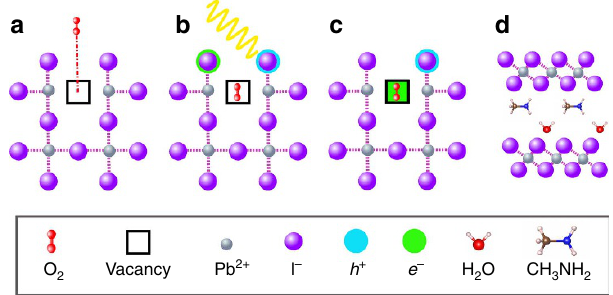
Figure 1 | Oxygen-induced photo-degradation. Schematic representation of the reaction steps of O 2 with CH 3 NH 3 PbI 3 . ( a ) Oxygen diffusion and incorporation into the lattice, ( b ) photoexcitation of CH 3 NH 3 PbI 3 to create electrons and holes ( c ) superoxide formation from O 2 , and ( d ) reaction and degradation to layered PbI 2 , H 2 O, I 2 and CH 3 NH 2